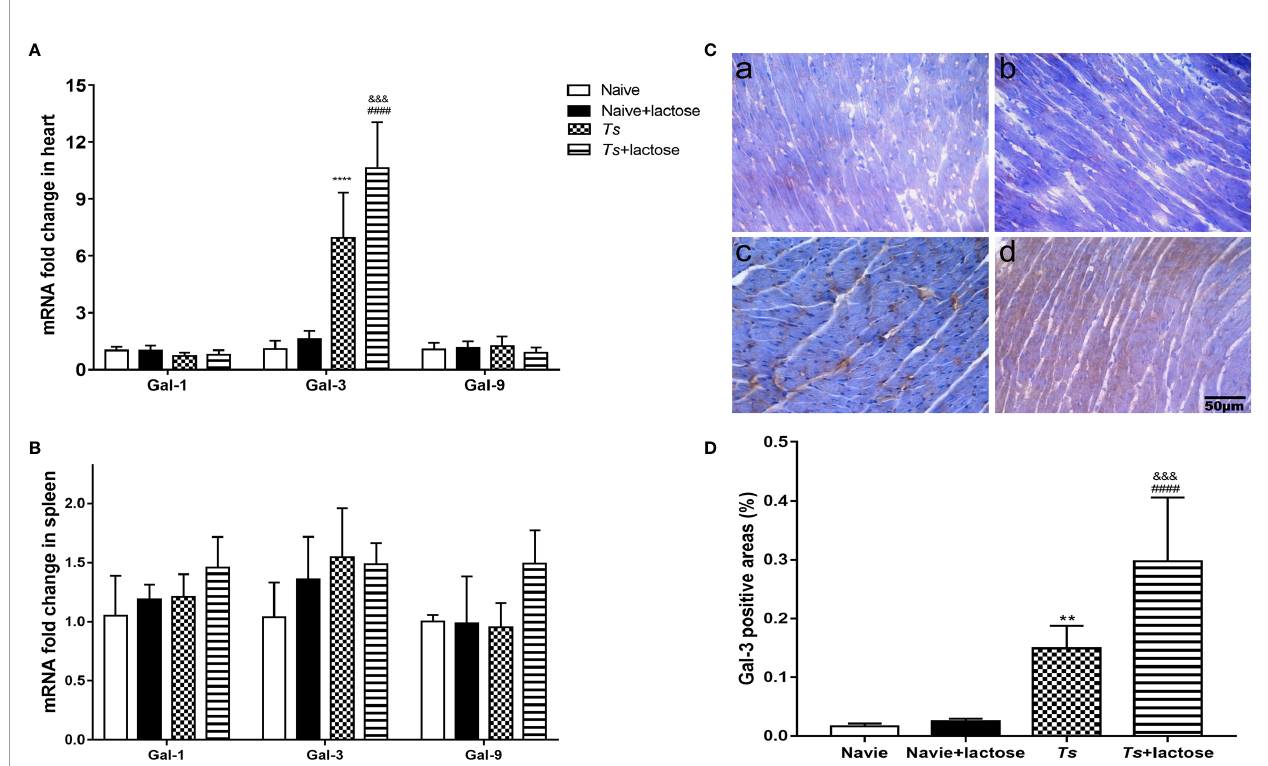
FIGURE 4 | The mRNA levels of Gal-1, Gal-3, and Gal-9 in the hearts (A) and spleens (B) , and immunohistochemical detection of Gai-3 (C) and quantitative analysis of Gal-3 positive areas in the hearts (D) of different groups of mice. The mRNA expression values are means from triplicate measurements and data are presented as means ± SD. Immunohistochemistry for Gal-3 (brown color) in the heart tissues of uninfected mice (a), uninfected mice with a -lactose treatment (b), T. spiralis -infected mice (c), and T. spiralis -infected mice with a -lactose treatment (d). Original magni fi cation 400× (scale bar = 50 µm). The positive area of Gal-3 was expressed as percentage. Data are presented as means ± SD; there were eight mice in each group and the data shown are representative of those from two different experiments. ** P < 0.01 and **** P < 0.0001 vs . uninfected control mice. #### P < 0.0001 vs . uninfected mice or uninfected mice with a -lactose treatment. &&& P < 0.001 vs . T. spiralis -infected